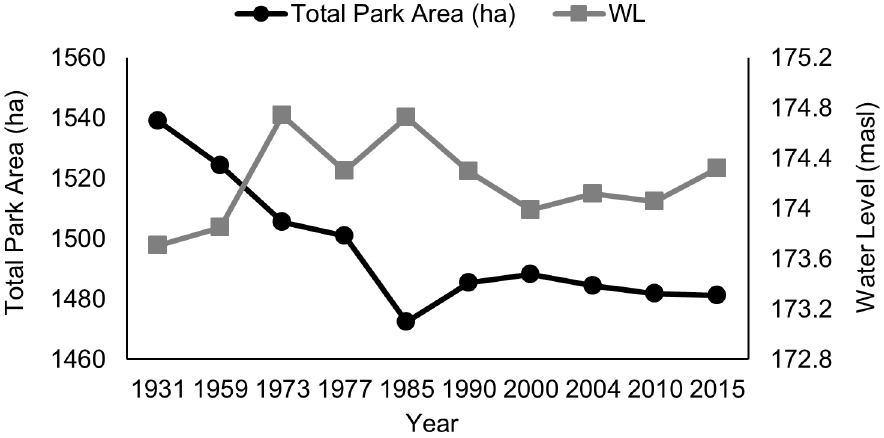
Fig 4. Total area of Point Pelee National Park from 1931 to 2015. A net loss of 58 ha was experienced over this time period. Years with a larger park area tend to be associated with higher water levels and vice versa.